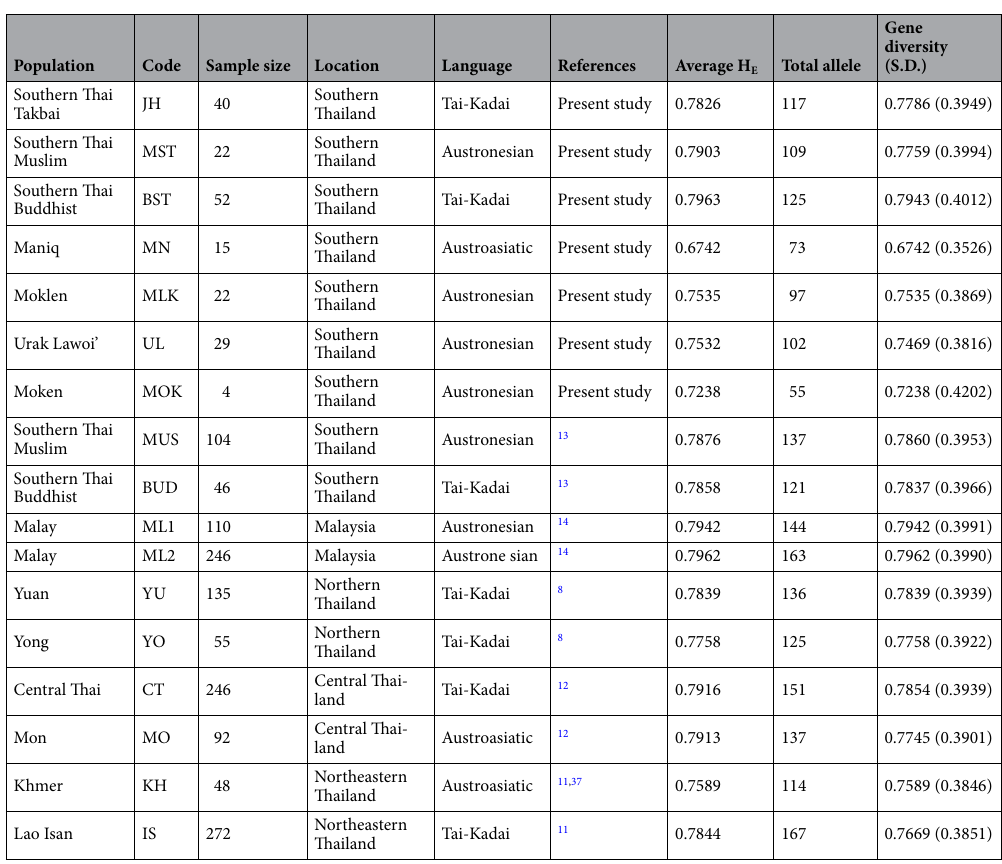
Table 1. General information and results on genetic diversities of the studied and compared